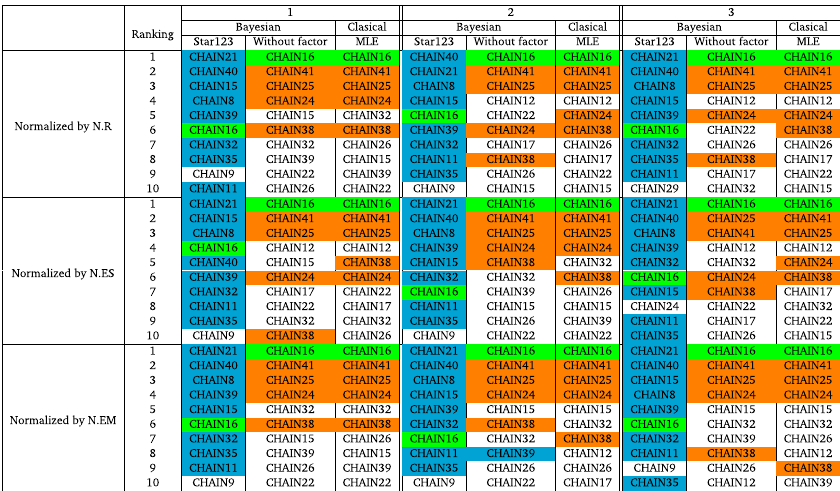
Table 7 Rankings of the top ten most efficient hotel chains under the three best models and different size normalizations